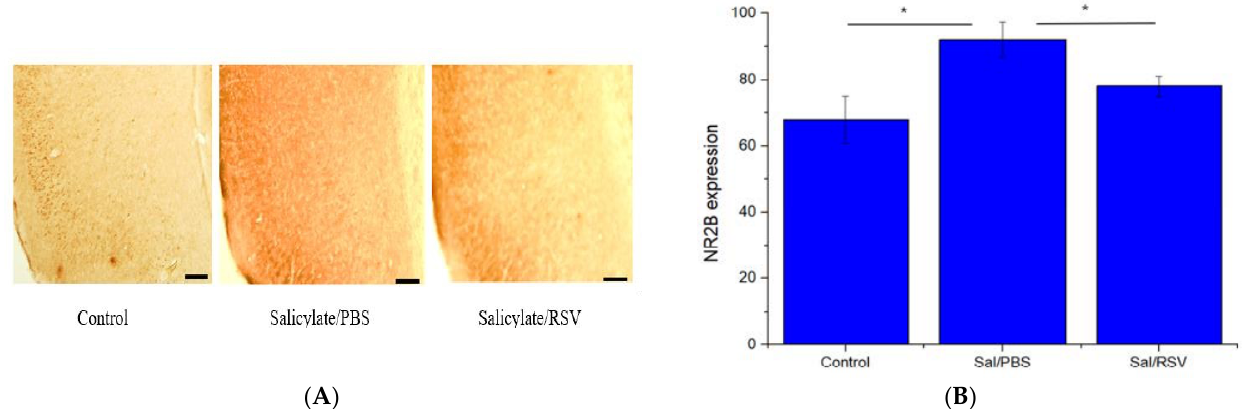
Figure 7. Resveratrol (RSV) attenuated NR2B expression in Sprague Dawley rats. NR2B expression in the control, salicylate/phosphate-buffered saline (PBS), and salicylate/RSV groups ( A ); scale bar: 100 µm, 100 × magnification. NR2B expression quantified using ImageJ. The salicylate/PBS group showed increased NR2B expression whereas RSV significantly attenuated NR2B expression ( B ); * p < 0.05. NR2B: NMDA receptor subunit 2B; PBS: phosphate-buffered saline.